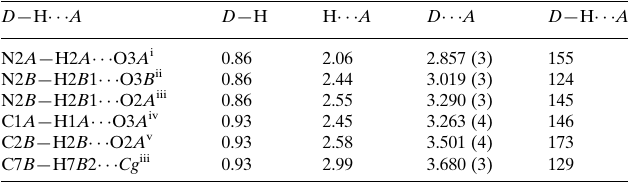
Hydrogen-bond geometry (A˚ , (cid:2) ). Cg is the centroid of ring C1 A –C6 A